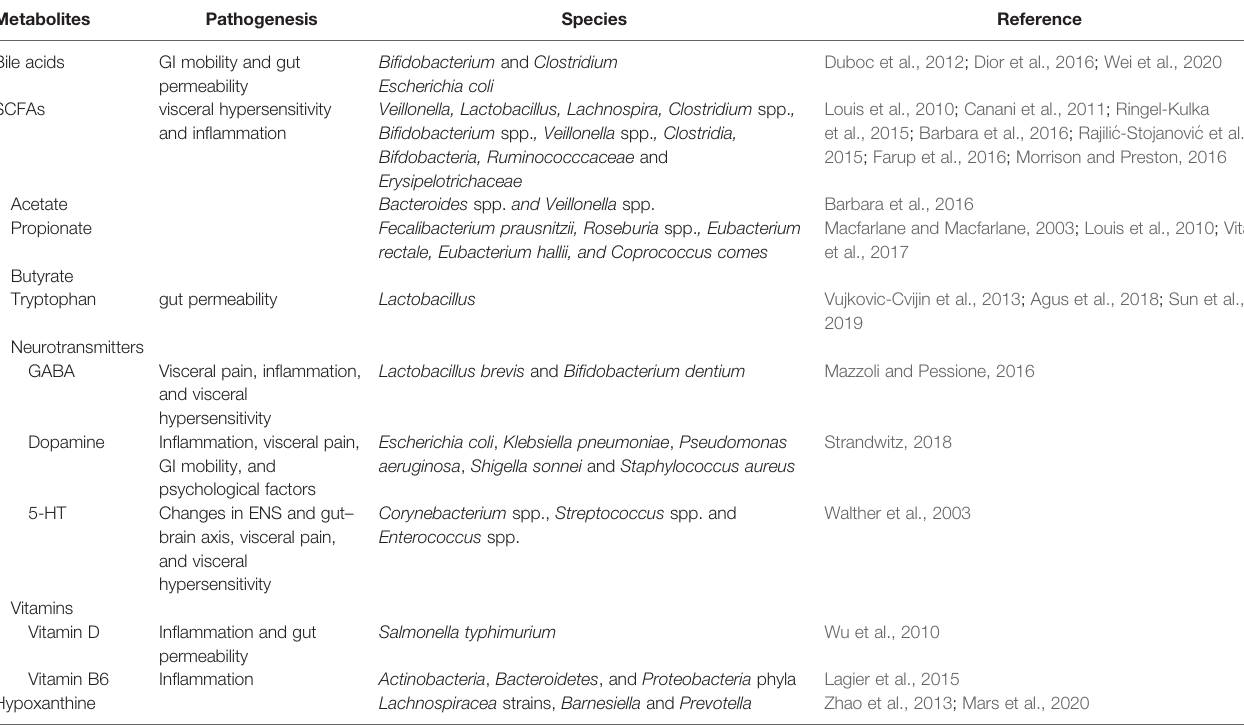
TABLE 1 | Gut microbiota-derived metabolites and associated genera or species in